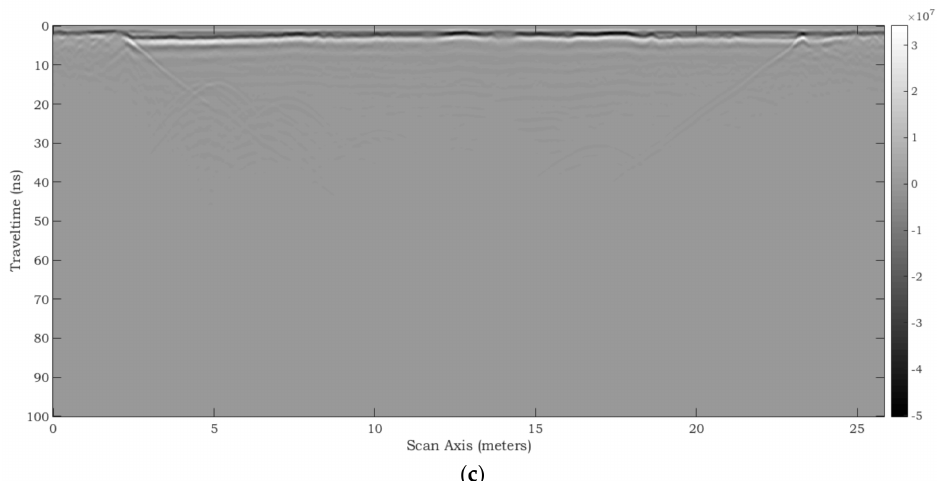
Figure 32. Profiles recorded in the Gneiss 14/20 gravel region by using GPR 1, on acquisition line 2, with ‘new’ antennas operating at: ( a ) 200 MHz; ( b ) 270 MHz; ( c ) 350 MHz.